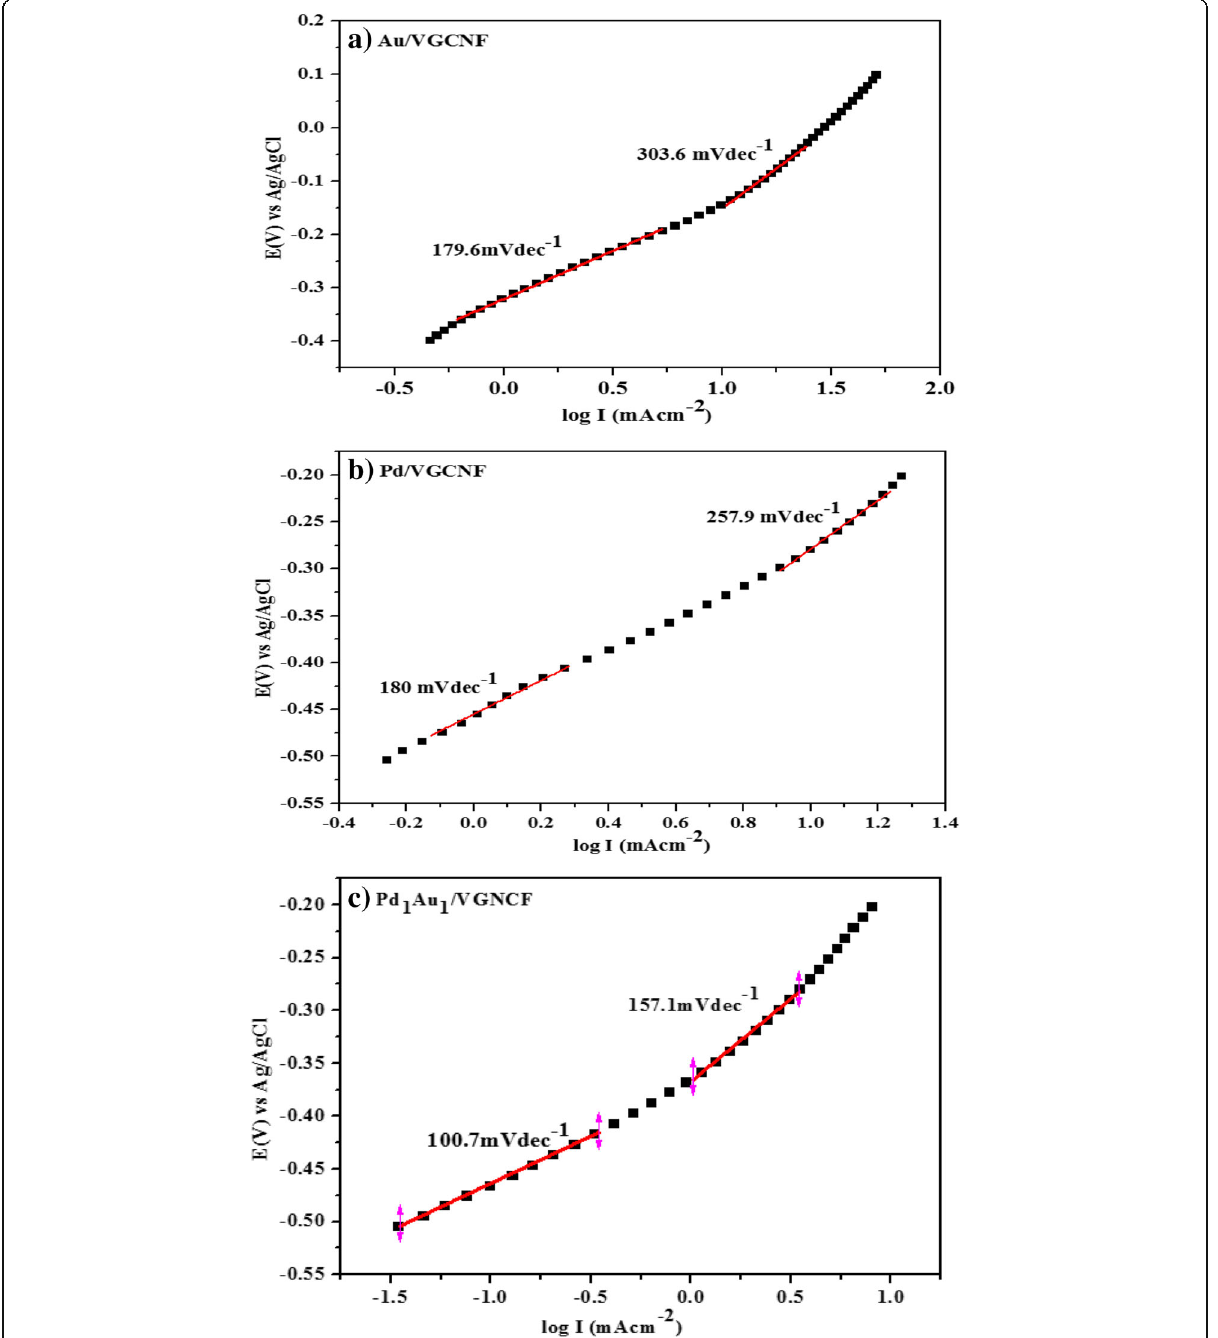
Fig. 7 Tafel slope for Au/VGCNF, Pd/VGCNF, and Pd 1 Au 1 /VGCNF electrocatalysts in solution (0.5 M NaOH+ 0.5 M Glycerol) at scanning rate 50 mVs −